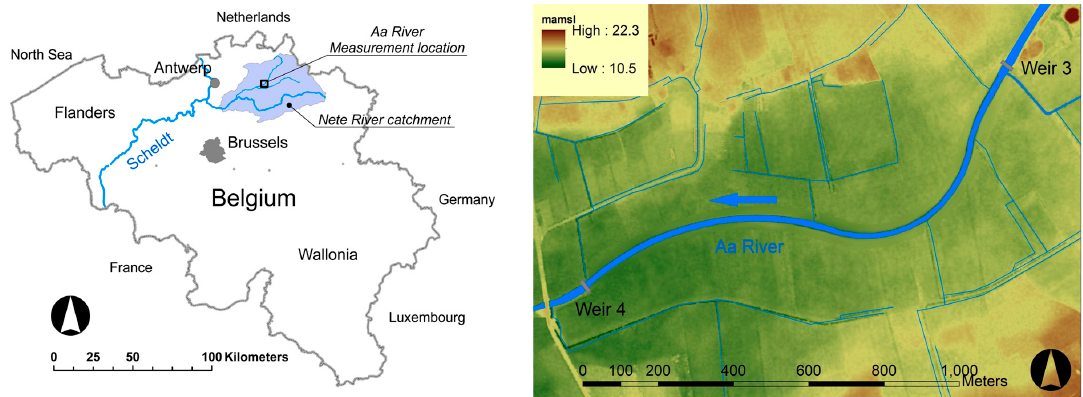
Figure 7. Location and topography map of the Aa River in Belgium.